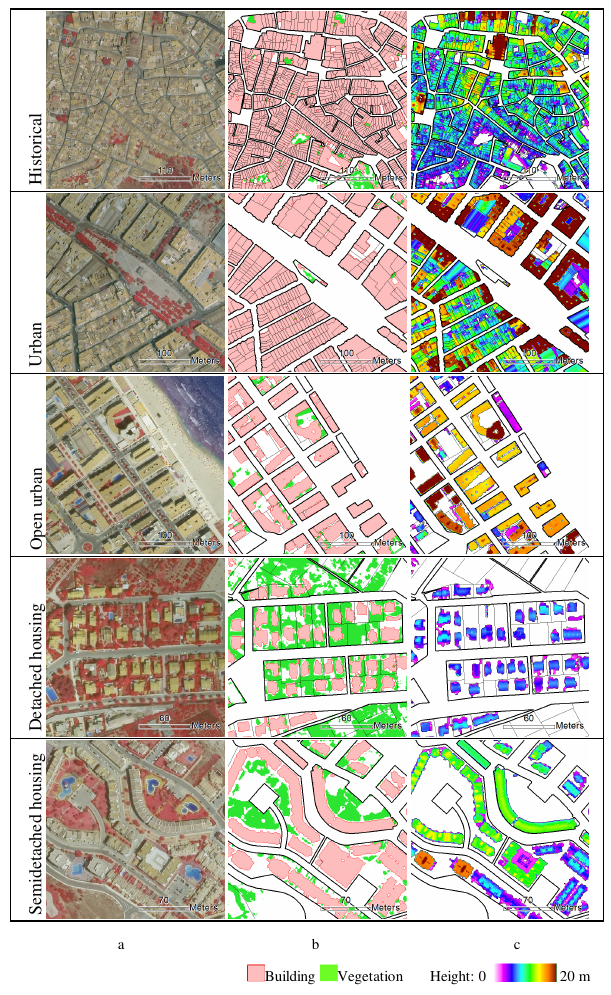
Figure 2. Examples of the urban classes defined in (a) colour infrared composition, and (b) details of the built-up and vegetation covered surface, and (c) distribution of building